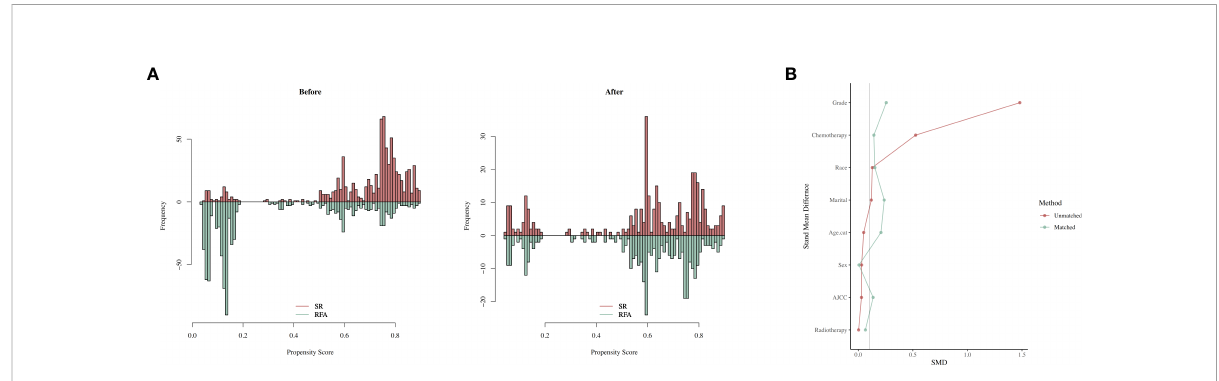
FIGURE 6 The balance before and after PSM. (A) Histogram showing the balance before and after PSM. (B) loveplot of